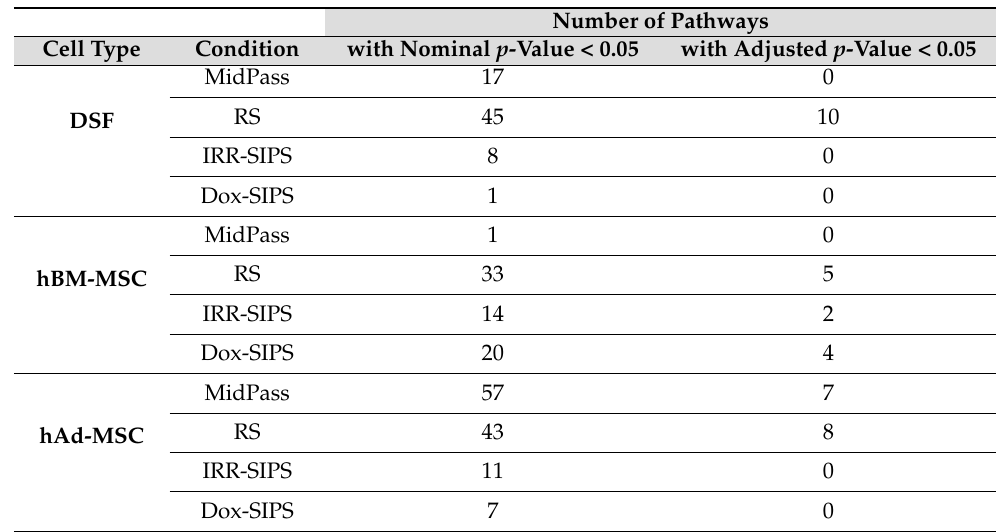
Figure 8. Overlap of differentially methylated ( a ) CpG sites and ( b ) genes in replicative senescence of all three cell types: DSF, hBM-MSC and hAd-MSC. Table 3. Number of KEGG pathways that were enriched in the sets of genes identified with at least one differentially methylated CpG when comparing treated cells with the respective early-passage